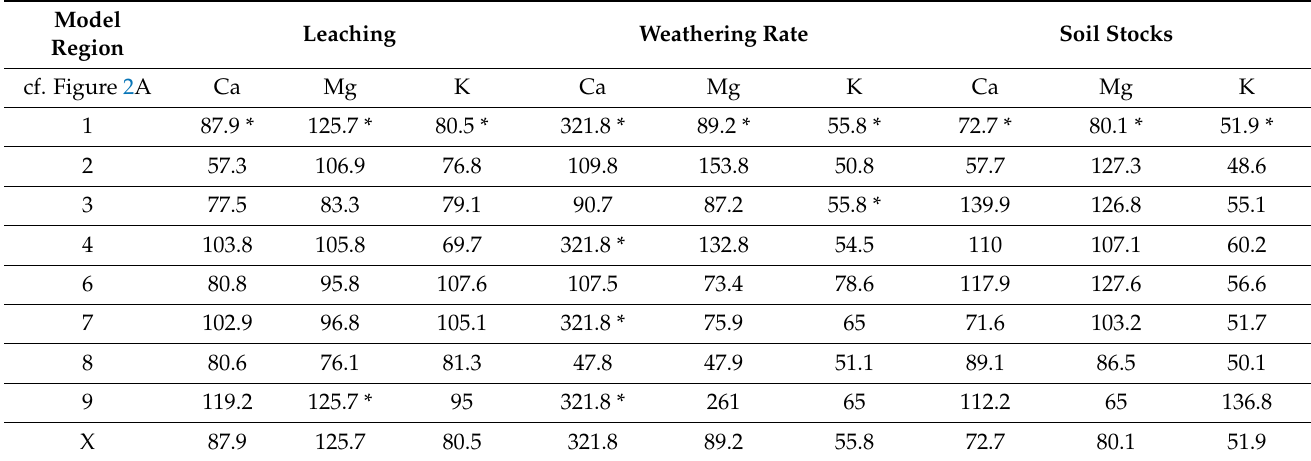
Table A4. Coefficient of variation (based on RMSE of the validation) of the regionalized balance elements for the individual model regions and the global model as a basis for the Monte Carlo simulations of the soil balances on the NFI tracts. Model Region (see Figure 2A, main text): 1: pre- alpine moraines and limestone Alps; 2: hills on limestone bedrocks; 3: hills on crystalline bedrocks; 4: hills on sand, silt, clay bedrocks; 6: old moraines, north German lowland; 7: young moraines, north German lowland; 8: loess regions, fluvial valleys; 9: hills on clay and silt schist bedrocks. Note: